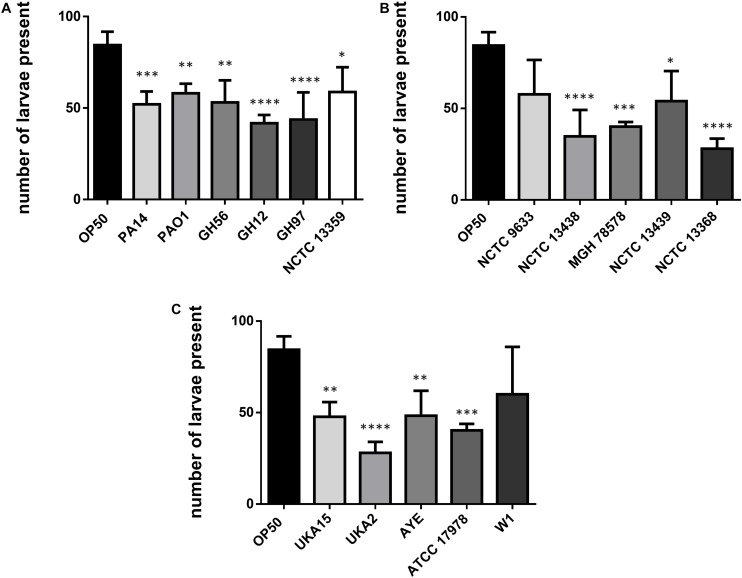
Number of C. elegans progeny after 48 h exposure to bacterial pathogens. Results are shown for P. aeruginosa
(A), K. pneumoniae
(B), and A. baumannii
(C) strains and were compared to E. coli OP50. These experiments were performed in at least triplicate for all strains. Error bars represent ± SEM. Analysis is by one-way ANOVA with Tukey’s multiple comparison. Significance relative to OP50 is shown. ∗P < 0.05, ∗∗P < 0.01, ∗∗∗P < 0.001, ****P < 0.0001.